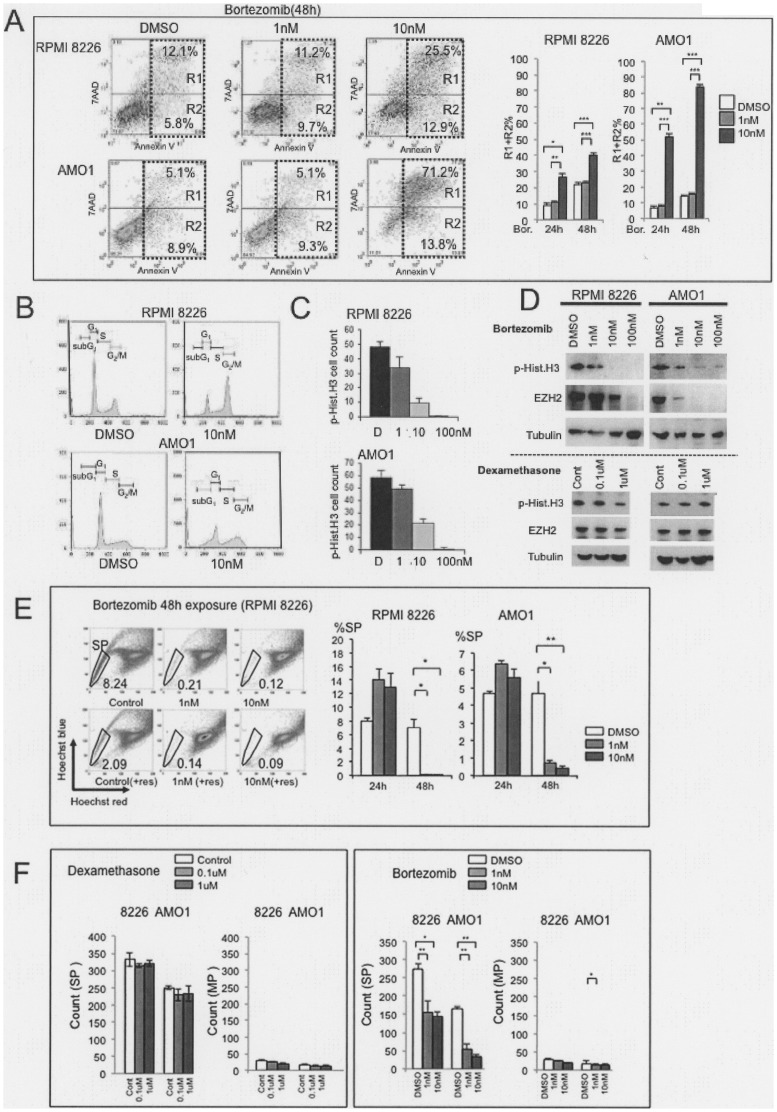
Reduction of the SP in MM cells treated with bortezomib.(A). Frequency of apoptosis of RPMI 8226 and AMO1. Left panels: dot plots showing the frequency of apoptosis at the indicated bortezomib (Bor.) concentrations (48 hr exposure). X-axis: cells stained with AnnexinV-PE. Y-axis: cells stained with 7-AAD. Right panels: bar graphs showing the % apoptotic cells (R1+R2) among examined cells treated with indicated concentration of bortezomib at 24 hr and 48 hr as indicated. Asterisks (*) indicate statistical significance: *0.01≤P<0.05, **0.001≤P<0.01, ***P<0.001. NS: not significant. (B). Cell cycle analysis RPMI 8226 and AMO1 treated with 10 nM bortezomib (24 hr). DMSO served as the control. RPMI 8226 control (+DMSO): subG1 3.9%, G0/G1 48.3%, S 19.2%, G2/M 28.6%; RPMI 8226+ bortezomib (10 nM): subG1 5.0%, G0/G1 20.1%, S 20.4%, G2/M 54.4%. AMO1 control (+DMSO): subG1 1.3%, G0/G1 58.4%, S 18.5%, G2/M 21.7%; AMO1+ bortezomib (10 nM): subG1 14.8%, G0/G1 31.6%, S 23.6%, G2/M 29.6% (C). Detection of M phase cells among bortezomib-treated (48 hr) myeloma cells. Bar graphs showing the numbers of M phase cells after treatment with DMSO, 1 nM, 10 nM and 100 nM bortezomib (24 hr exposure.) (D).Western blot analysis of p-Hist.H3 and EZH2 in RPMI 8226 (left panel) and AMO1 (right panel) cells after treatment with the indicated concentration of bortezomib and dexamethasone (48 hr). (E). Flow cytometric analysis of RPMI 8226 SP cells treated with bortezomib. Upper left panels: Dot plots of cells stained with Hoechst 33342 alone, Hoechst 33342 in the presence of 1 nM bortezomib for 48 h, or Hoechst 33342 in the presence of 10 nM bortezomib for 48 h. Lower left panels: cells treated as in the upper panels with 50 µM reserpine (shown as “res”). SP cell fractions (%) after treating RPMI 8226 and AMO1 cells are also shown besides the flow cytometric analysis. (F). CFC assay. Colonies of SP and MP by dexamethasone (left panel, Control (1 µl of 100% ethanol), 0.1 µM, 1 µM) and bortezomib (right pane, DMSO, 1 nM or 10 nM) for indicated cell lines. Asterisks (*) indicate statistical significance: *0.01≤P<0.05, **0.001≤P<0.01, ***P<0.001. Bars are means ± SD of three independent experiments.